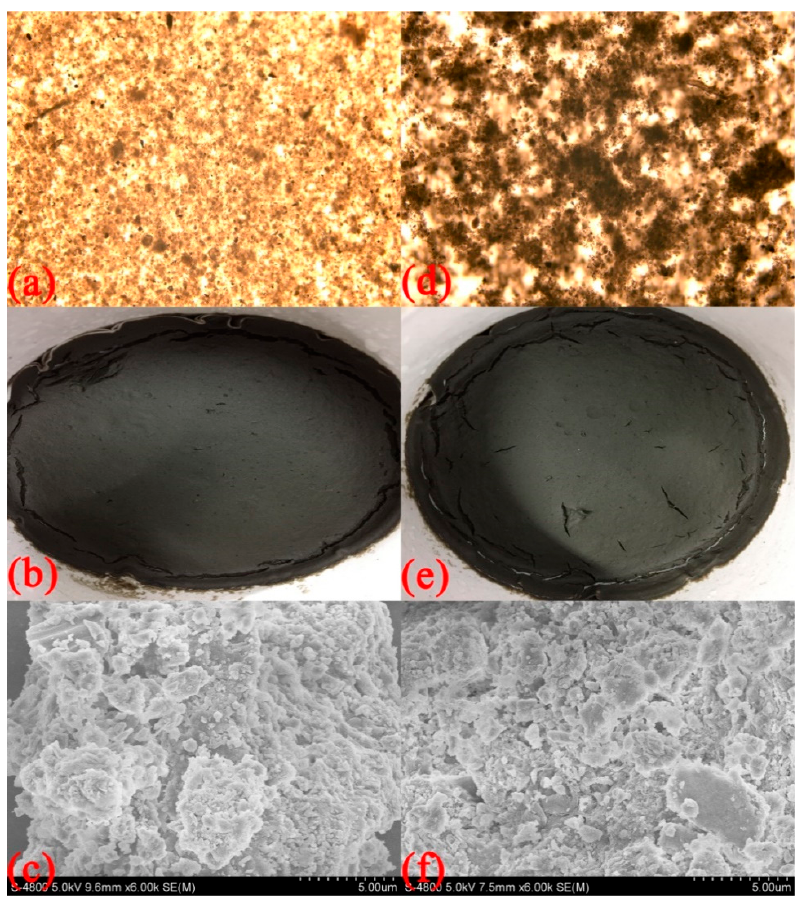
Figure 10. SEM images and photographs of sludge: ( a – c ) original sludge, ( d – f ) sludge conditioned by CCPAD.